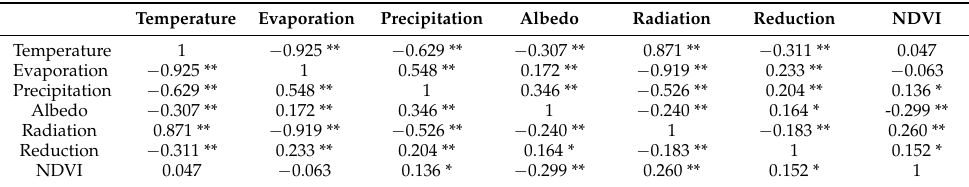
Table 3. Correlation matrix for the selected